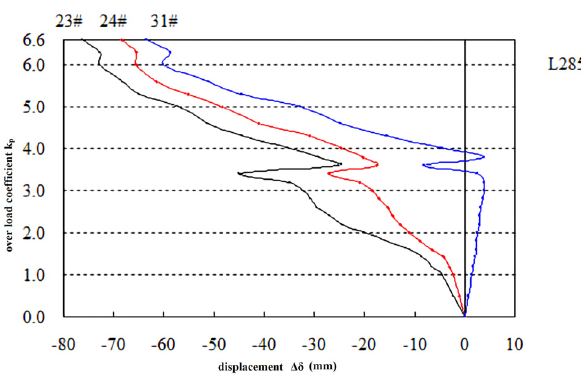
Figure 7: The relative displacement Δ δ – K p curve of Lp285.